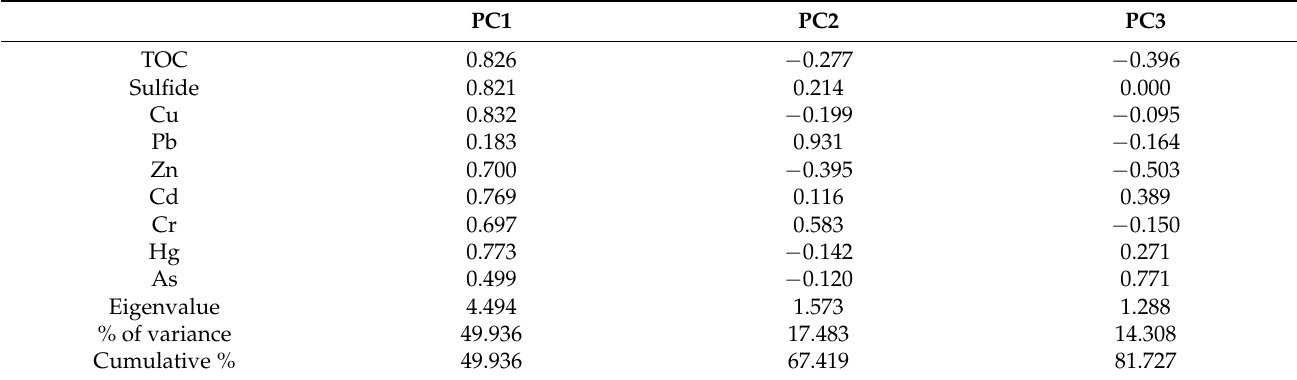
Table 3. Results of the principal component analysis for heavy metals, TOC, and sulfide in the surface sediment of Weitou